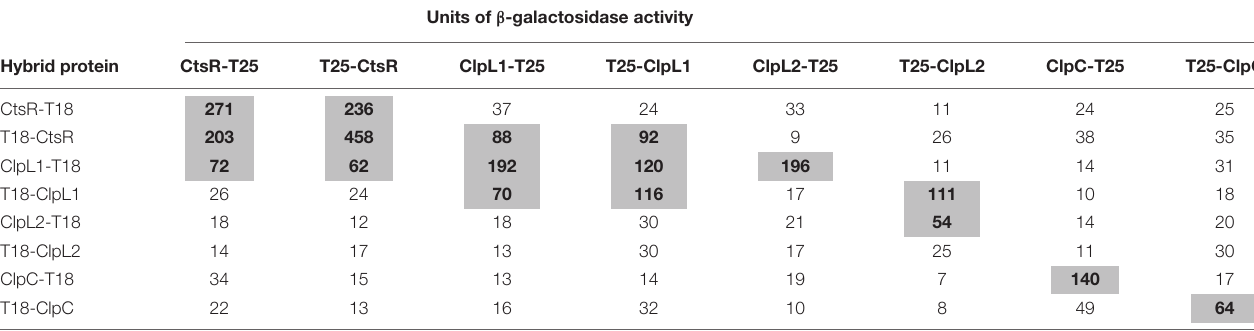
TABLE 3 | BACTH analysis of CtsR, ClpL1, ClpL2, and ClpC interactions 1 .